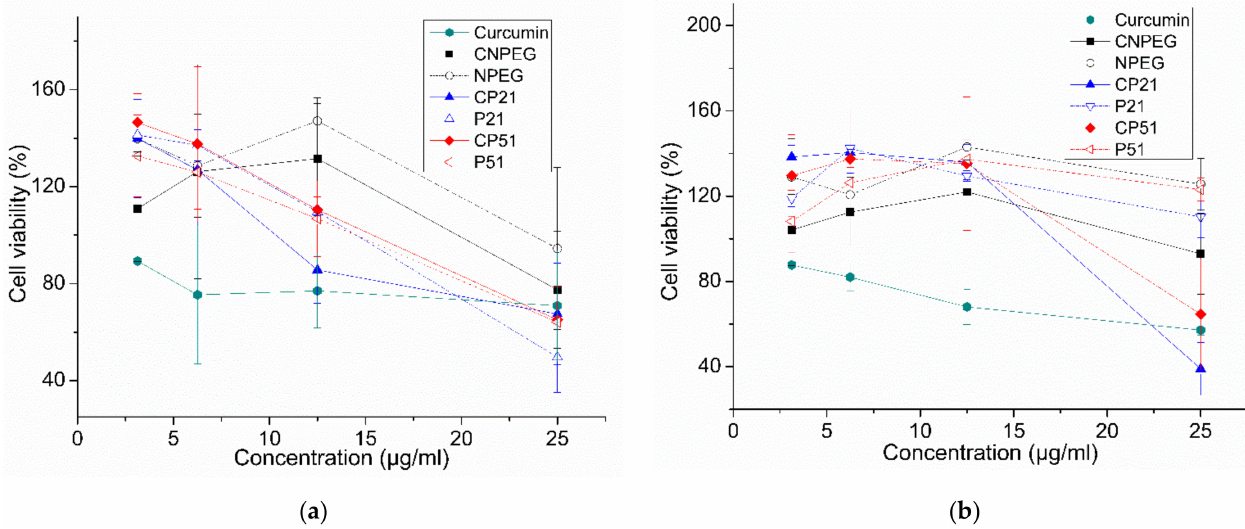
Figure 7. Cell viability (%) for investigated formulations evaluated for ( a ) MRC-5 cell line and ( b ) LS-174. All values are presented as mean ± sd ( n =